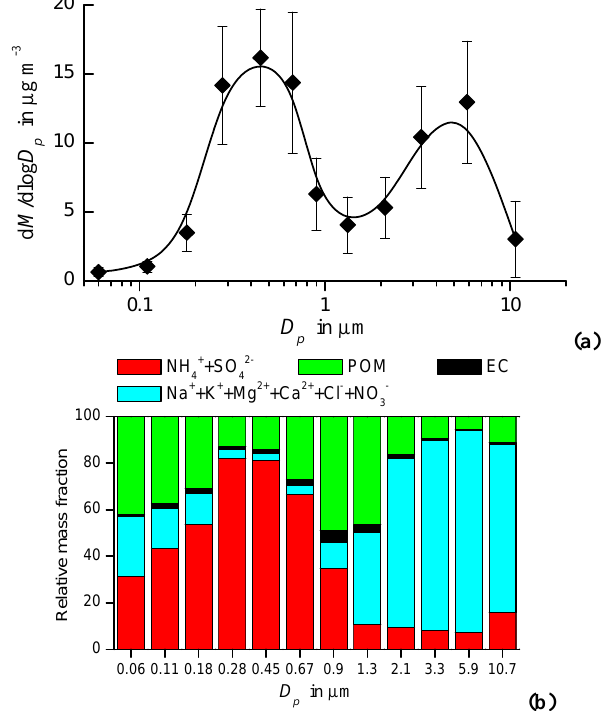
Fig. 2. Mass size distribution and chemical composition of aerosol particles during ARIADNE: (a) average mass size distribution with one standard deviation, (b) chemical composition, classified into four groups including ammonium sulfate (NH + processed sea-salt (Na + +K + +Mg 2 + +Ca 2 + +Cl − +NO − tal carbon (EC) and particulate organic matter